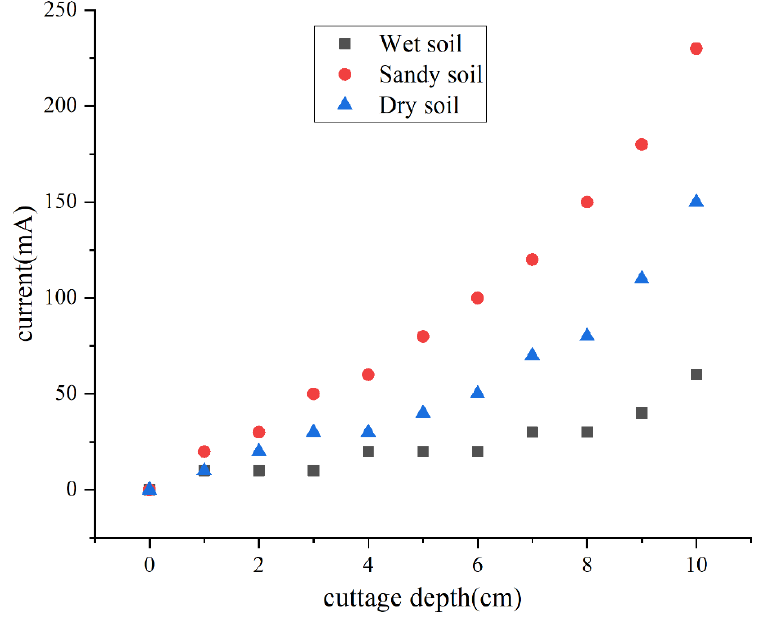
Figure 15. The verification experiment of the “current depth” real-time feedback.